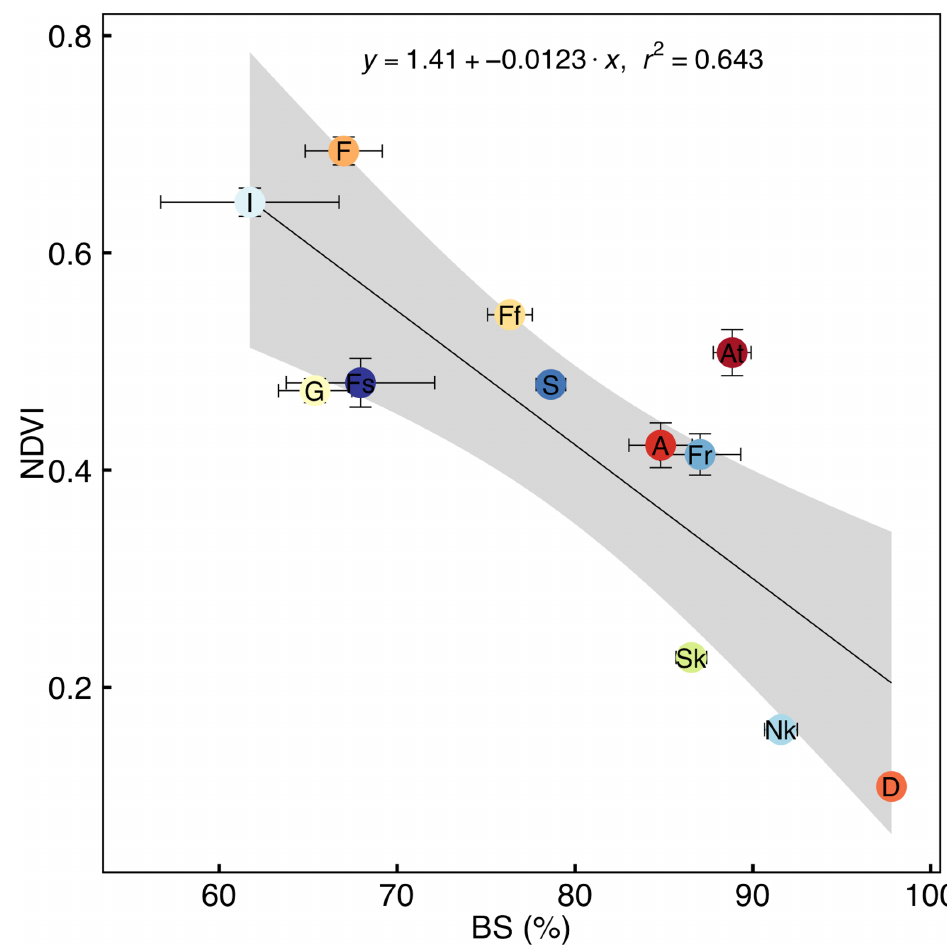
Fig 4. Correlation of annual average normalised difference vegetation index (NDVI) with base saturation (BS) of each vegetation type. The vegetation types are indicated by codes (see Table 1). The coefficient of determination (r 2 ) is shown for significant relationships (P < 0.05). Points and error bars indicate mean ± SE (for n see Table 1) and the grey band indicates the 95% confidence limits.